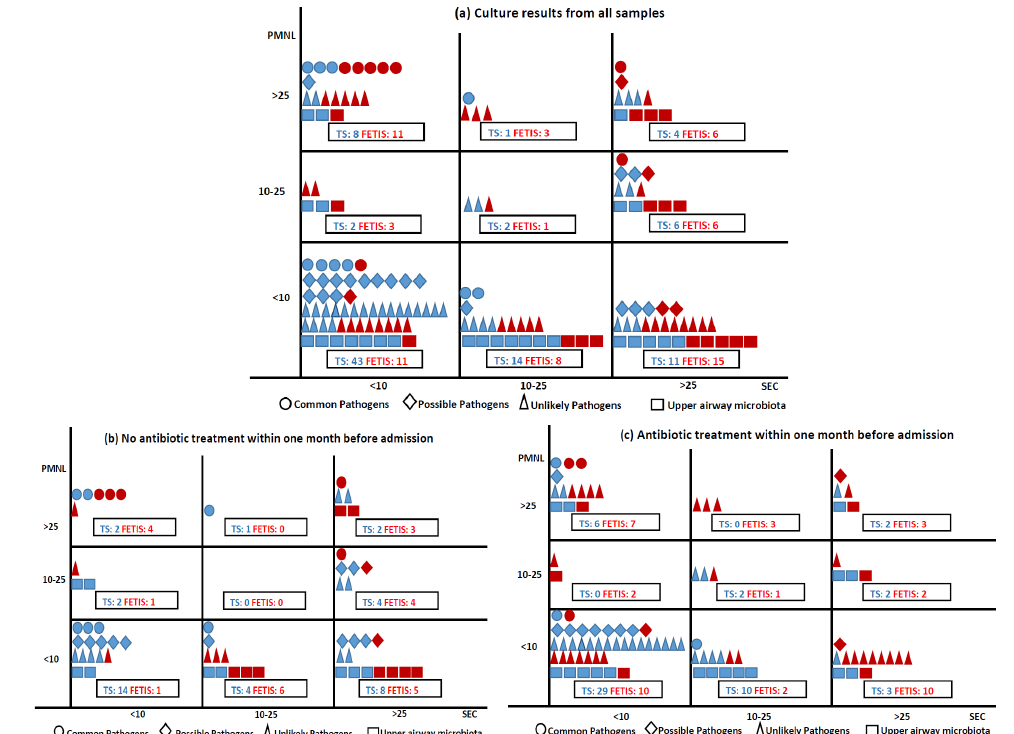
Figure 2. Samples collected by TS and FETIS distributed according to Gram stain quality criteria, culture results ( a ), and samples without and with prior antibiotic treatment ( b , c ). Sampling methods: TS blue, FETIS red. Culture results are presented in four groups: : common pathogens of CA-LRTI (cid:35) ( S. pneumoniae , H. influenzae , and M. catarrhalis ), ♦ : possible pathogens of CA-LRTI ( P. aeruginosa S. maltophila , S. agalactiae , and yeast), and (cid:3) : upper airway microbiota. A total of 9 culture results